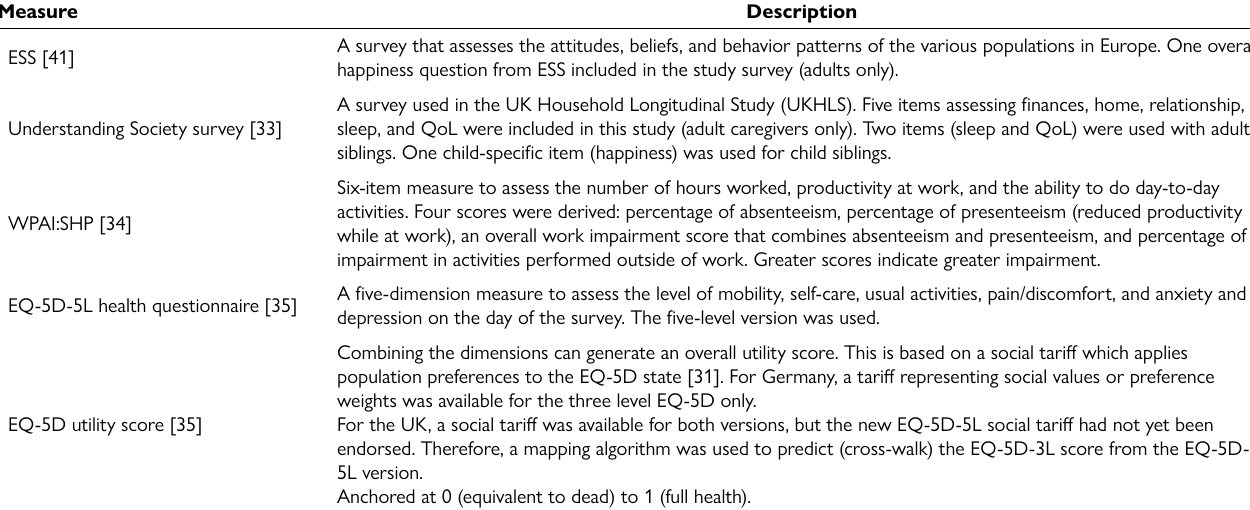
Table 2. Descriptions of national wellbeing and quality of life measures used in the survey